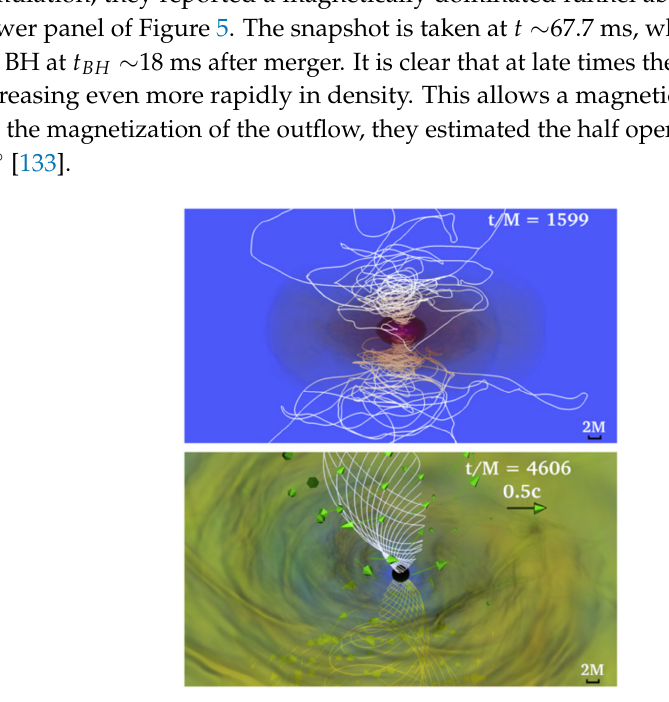
Figure 5. Snapshots of the rest-mass density of a model from [133]. Magnetic field lines are depicted as white lines and arrows indicate plasma velocities. In this model, the merger remnant collapses to a BH at t BH ∼ 1215 M = 18 ms after merger. The upper panel is at a slightly later time after collapse, whereas the lower panel is at t ∼ 67.7 ms. We point out that, while the density contours are selected far from the magnetic jet structure, the funnel is filled with low density matter which supports the collimation of the magnetic structure. The length scale of the plots is M = 4.43km. (Reprinted from [133]. c (cid:13) AAS. Reproduced with